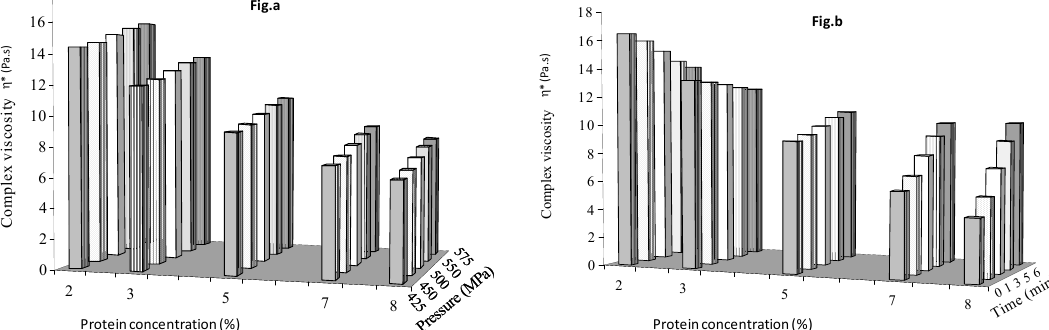
Figure 7. Effect of protein concentration ( a ) pressure and ( b ) holding time on complex viscosity of mango puree.